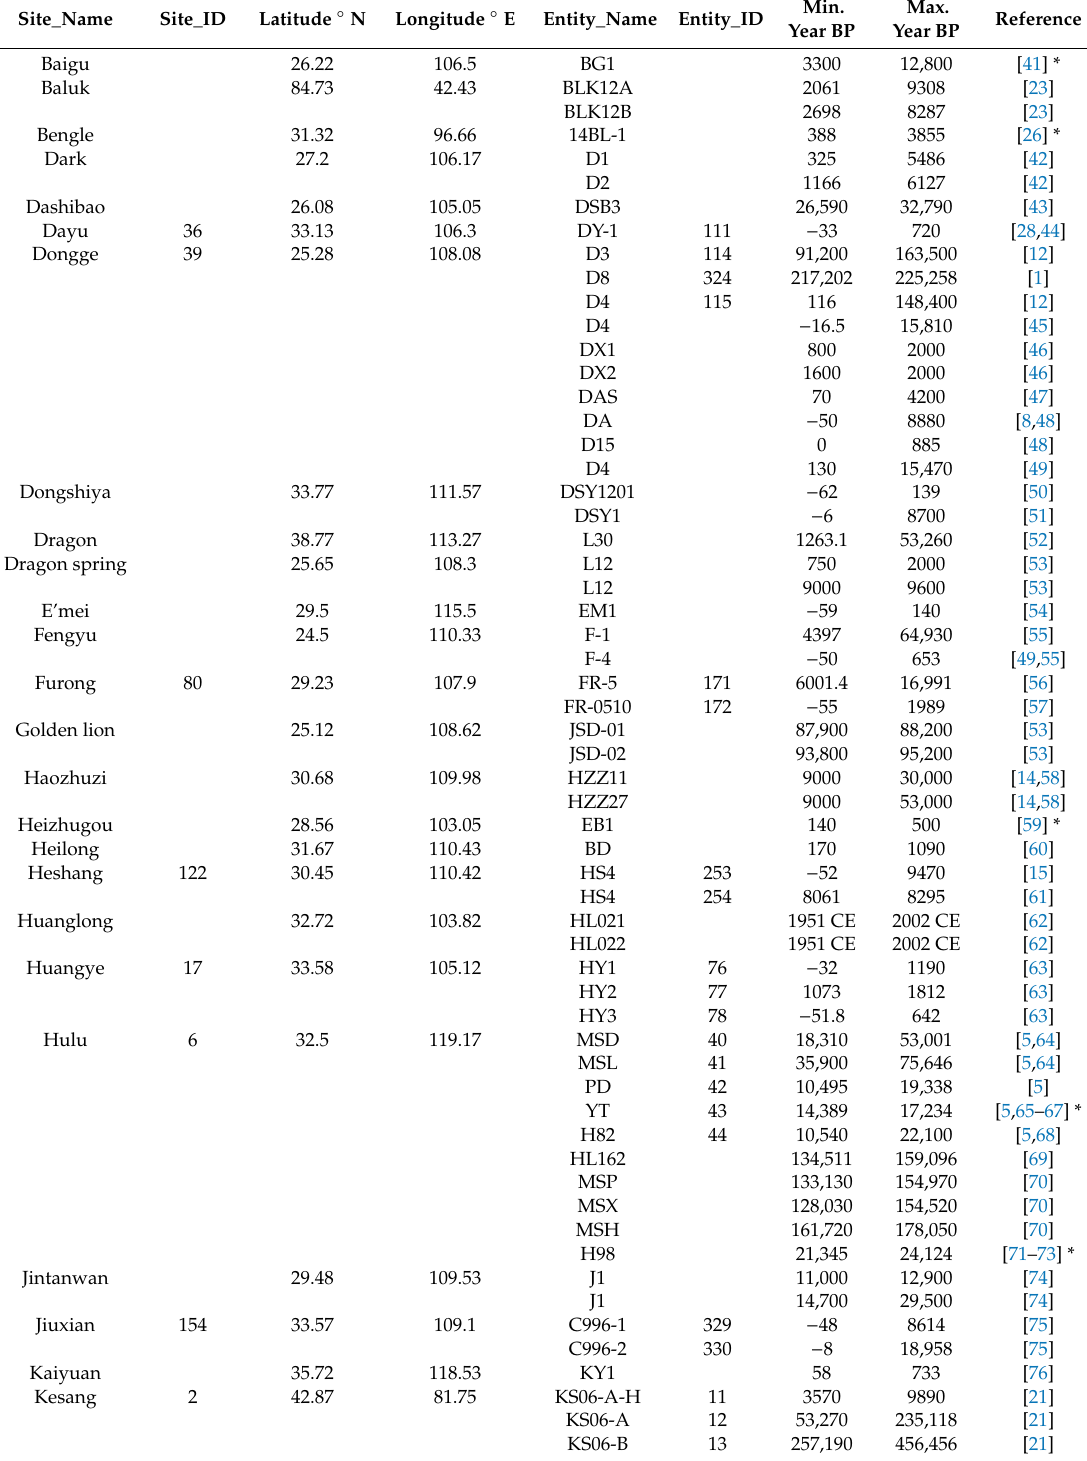
Table 1. Summary of Chinese speleothem records sorted alphabetically by site name. The records for which entity_ID is available are in SISAL_v1 [19]. Min / Max year BP correspond to the last / first stable isotope measurement of each record. BP is years before present, where present is 1950 CE. * indicates the papers published in Chinese